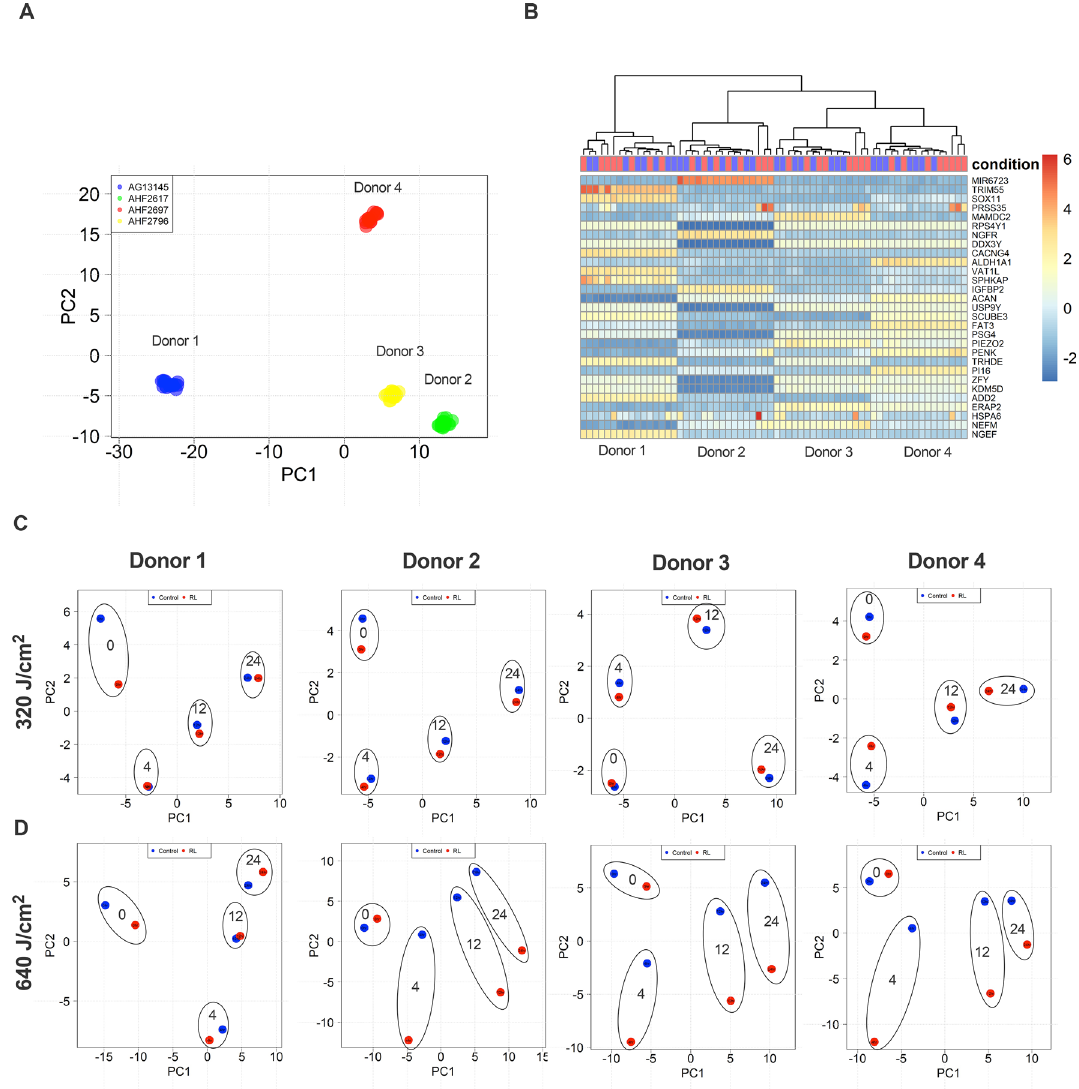
Figure 1. Characteristics of HDF Donors following RL treatment. RL treated and control samples cluster according to donor and time. (A) Combined sample donor PCA demonstrating clustering within donors. PCA plots are regularized log-transformed data and were created with the DESeq2 bioconductor R package. The original count data was transformed to the log 2 scale to minimize differences between samples for rows with small counts, normalizing according to library size. After transformation, the top 500 rows with the highest variance were used for further principal component analysis. (B) Heat map cluster of a subset of the top 30 most highly variable genes. Blue and red bars on the condition row represent control and RL treated samples, respectively. (C) PCA of individual sample donors 1–4 for 320 J/cm 2 and (D) 640 J/cm 2 fluences demonstrates clustering of 0-h time points from 4, 12, and 24 h time points. Control (blue) and RL (red) treated samples are circled and labeled by time point (i.e., 0, 4, 12, and 24